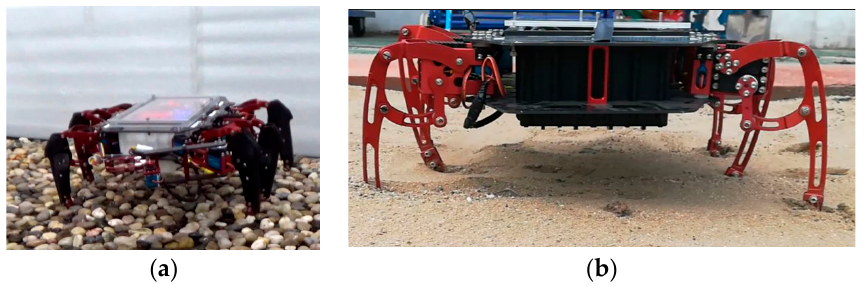
Figure 10. The walking experiment simulated an amphibious environment site. ( a ) is the gravel ground. ( b ) is the sand ground.